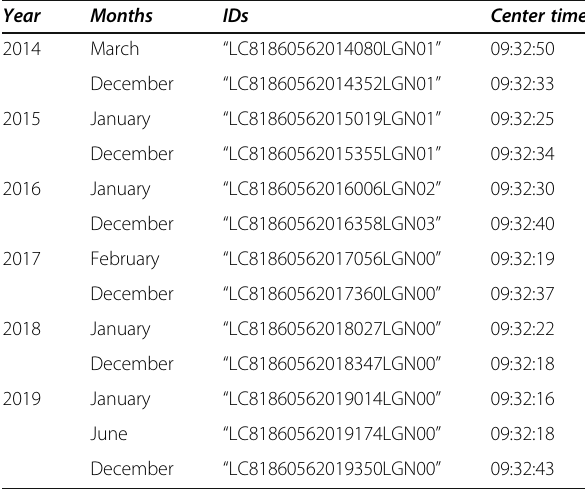
Table 14 Information on Landsat 8 images used (https:// earthexplorer.usgs.gov)